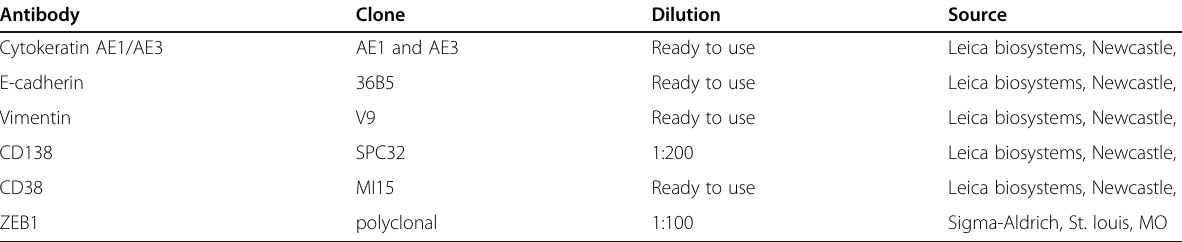
Table 1 Antibodies used for immunohistochemical study Antibody Clone